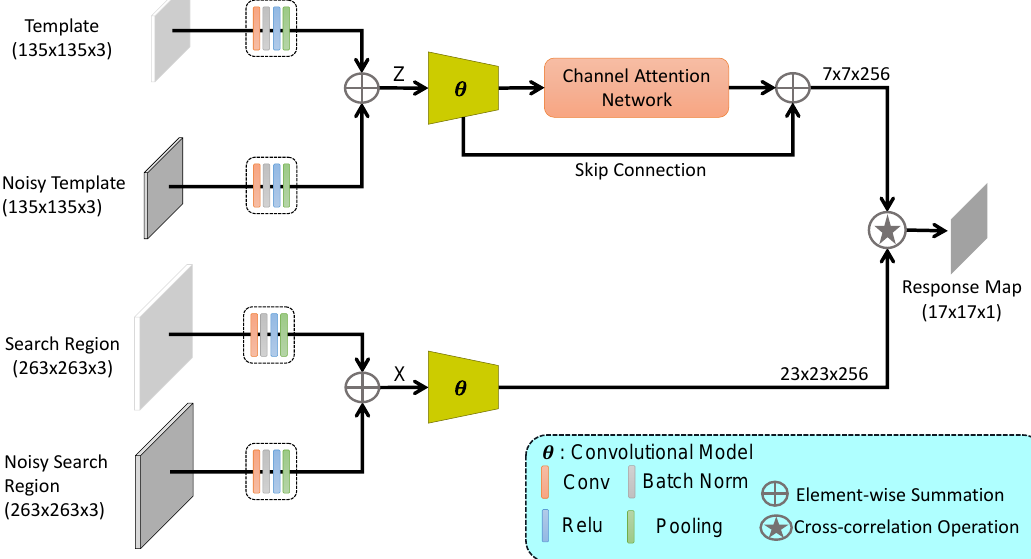
Figure 1. Proposed IRCA-Siam tracking framework. The inputs are fused after MaxPool layer for exemplar and search branches. Channel attentional network is integrated for exemplar branch using a skip